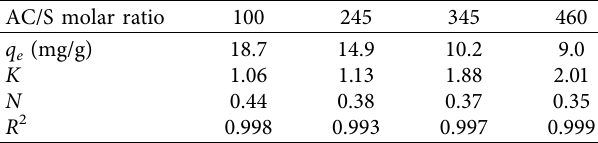
Figure 10: (a) Influence of cyclic adsorption on SO 2 removal rate. (b) Influence of circulating ratio on SO 2 removal rate. The temperature is 65 ° C, AC/S mole ratio is 300, and SO 2 , O 2 , and H 2 O concentration is 0.1%, 6%, and 8%. Table 2: The parameters of Bangham model of Figure 5(b).